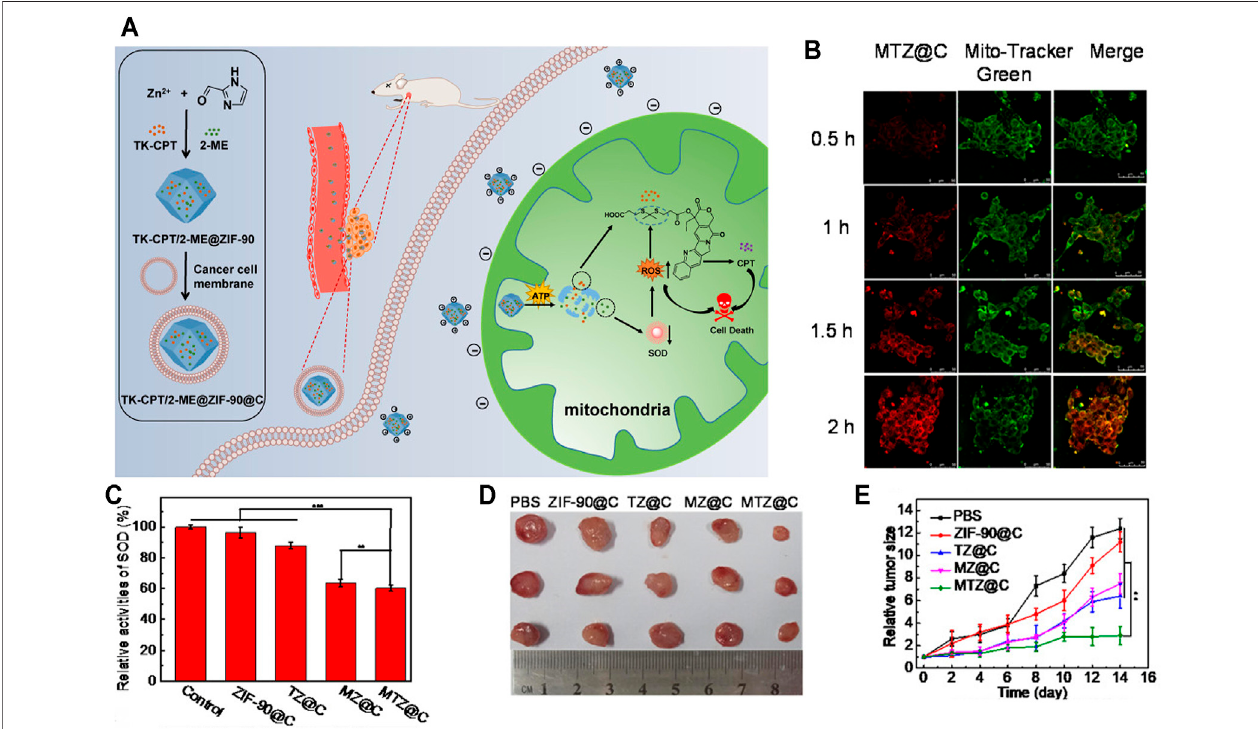
FIGURE 3 | (A) Schematic illustration of the preparation of ATP-triggered 2-ME/TK-CPT@ZIF-90@C (MTZ@C) nanoparticles to initiate mitochondrial cascade reactions. When MTZ entered mitochondria, 2-ME was released owing to the ATP-triggered ZIF-90 decomposition. Then, 2-ME ampli fi ed the level of ROS in mitochondria, thus facilitating the effective release of parent CPT. (B) MTZ@C mitochondrial targeting ability. (C) SOD activity inhibition of 2-ME. (D) Dissected tumor images after administration for 2 weeks. (E) Tumor growth curves within 2 weeks after administration (Pan et al., 2021).